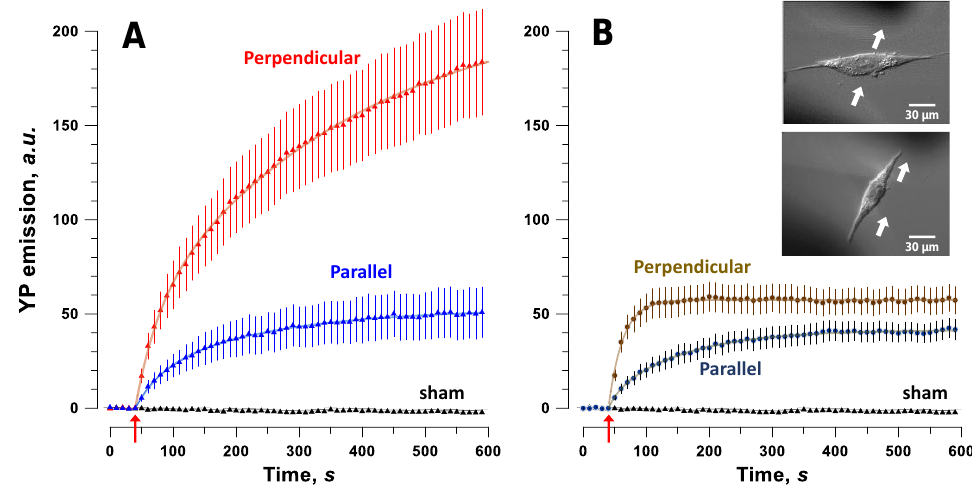
Figure 4. Smooth muscle cell orientation affects cell permeabilization with nanosecond pulses ( A ) more than with microsecond pulses ( B ). Permeabilization was measured by YP dye emission change following PEF treatment (arrow). ( A ) Cells were permeabilized by a train of ten, 300-ns pulses at 10 kV/cm, 5 Hz. ( B ) Cells were permeabilized by a train of ten, 20-µs pulses at 0.68 kV/cm, 5 Hz. Mean ± SEM, n = 12–17. YP uptake was significantly higher ( p < 0.01) throughout the observation period ( A ), or only during the first minute ( p < 0.05, ( B )). Insets show an SMC between two electrodes (shadows) oriented either perpendicular or parallel to the electric field (top and bottom, respectively; arrows show the electric field direction).